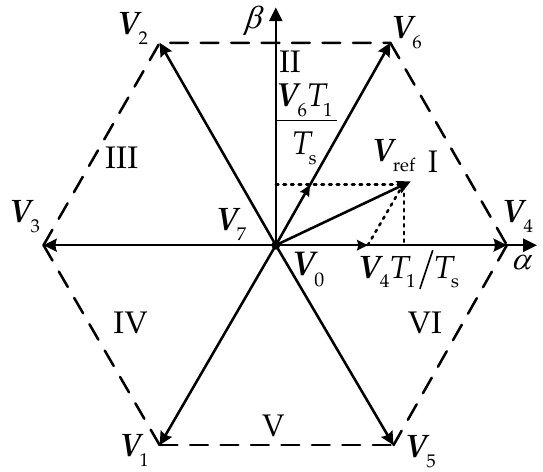
Figure 2. Principle of space vector composition.